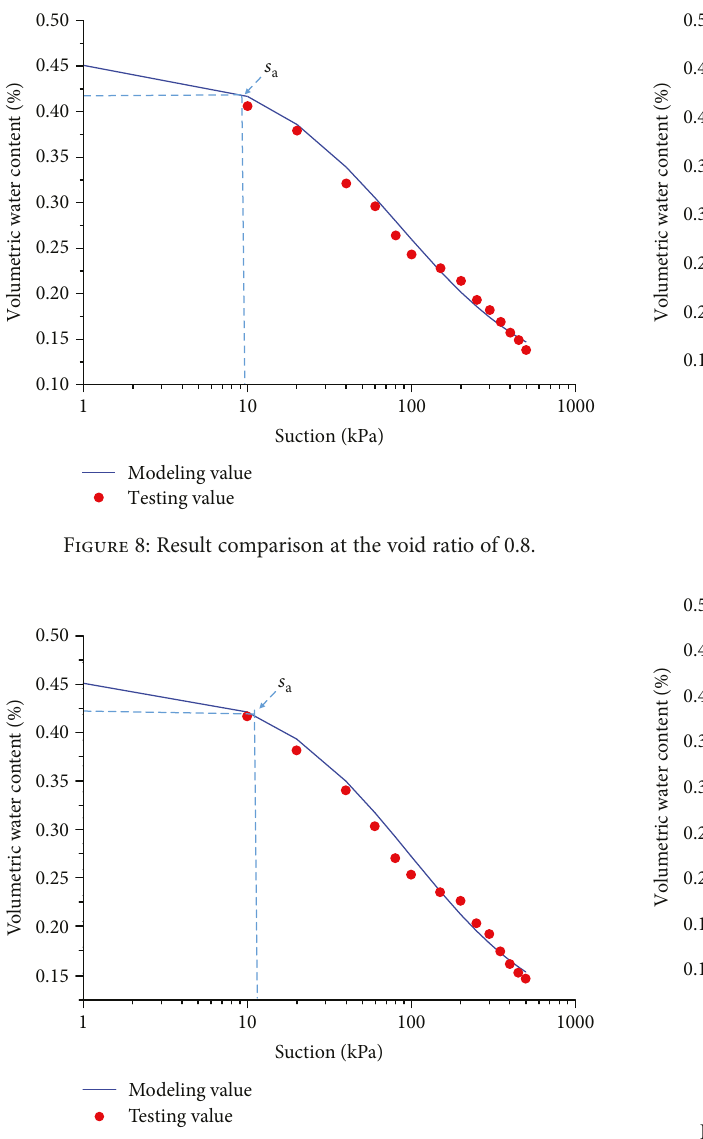
Figure 9: Result comparison at the void ratio of 0.75.